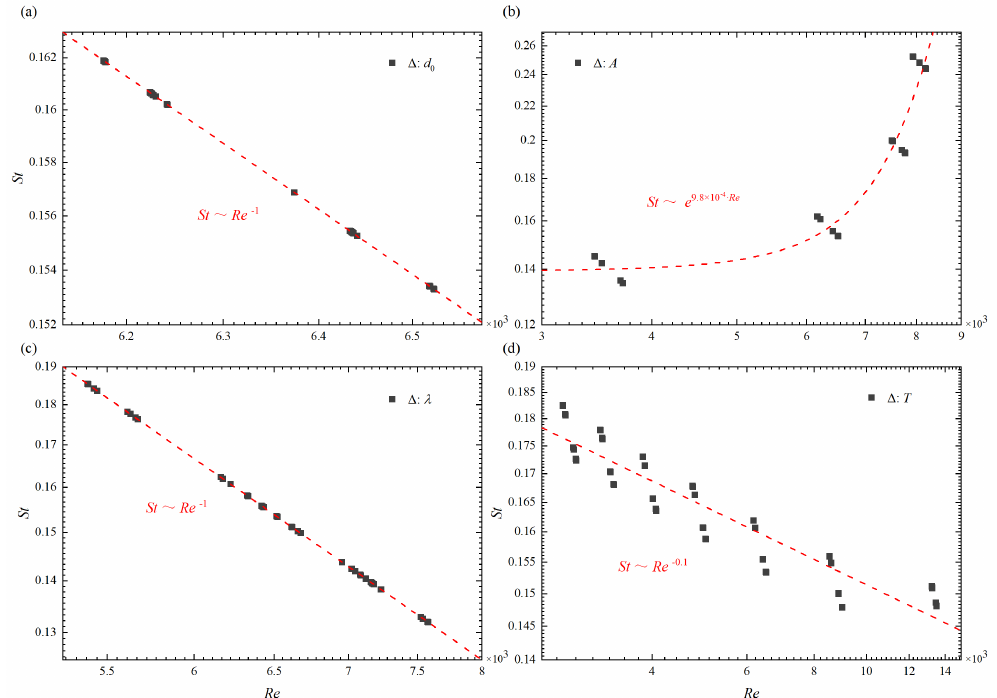
Figure 9. The Reynolds number in different ( a ) initial separation distance d 0 , ( b ) tail beat amplitude A , ( c ) wave length λ , and ( d ) period of oscillation T as a function of the Strouhal number. The red dash-dot line in panel represents the scaling law for the Reynolds number and the Strouhal number, where “ ∆ ” represents the swimming parameters